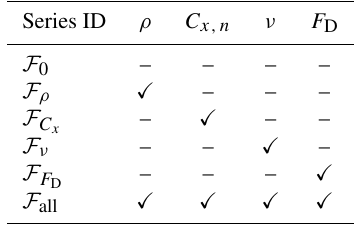
Table 3. Main series of simulations discussed in the study with information on activated ( (cid:88) ) and deactivated (–) frazil interaction mechanisms. Series ID ρ C